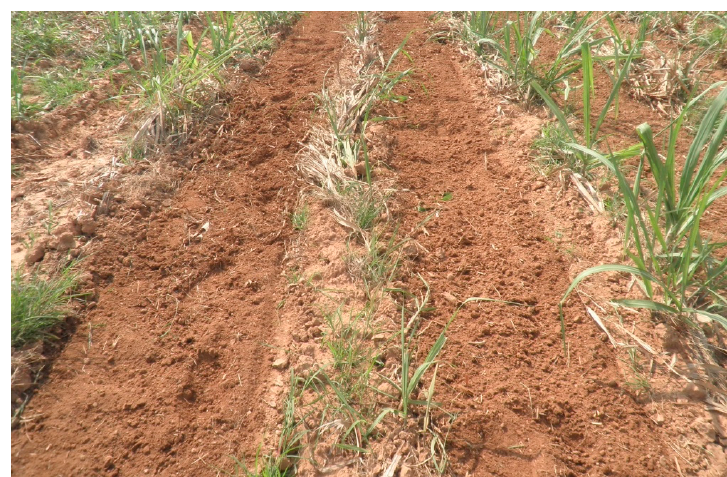
Figure 8. Inter-row cultivator operating in the field.